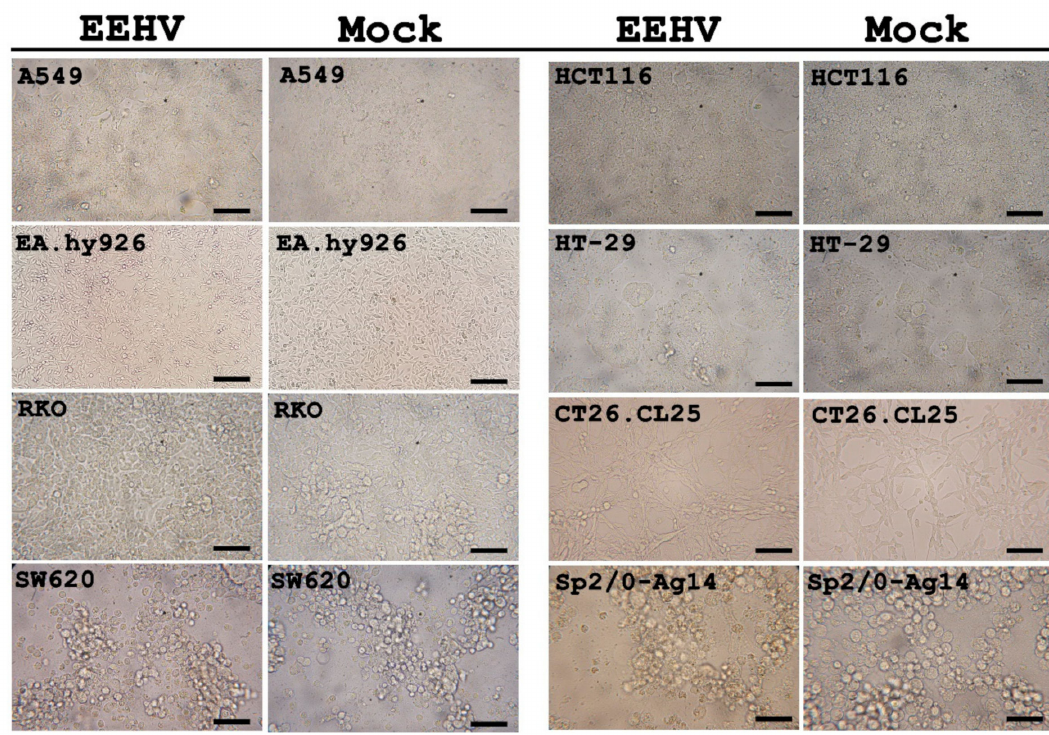
Figure 1. Cell morphology of the A549, HCT116, EA.hy926, HT-29, RKO, CT26.CL25, SW620 and Sp2 / 0-Ag-14 cells after being inoculated with the EEHV inoculum. At 72 hpi, there were no obvious cytological changes to the EEHV-inoculated cells when compared with the mock-infected control. Scale bars ~200 µ m. EEHV: elephant endotheliotropic